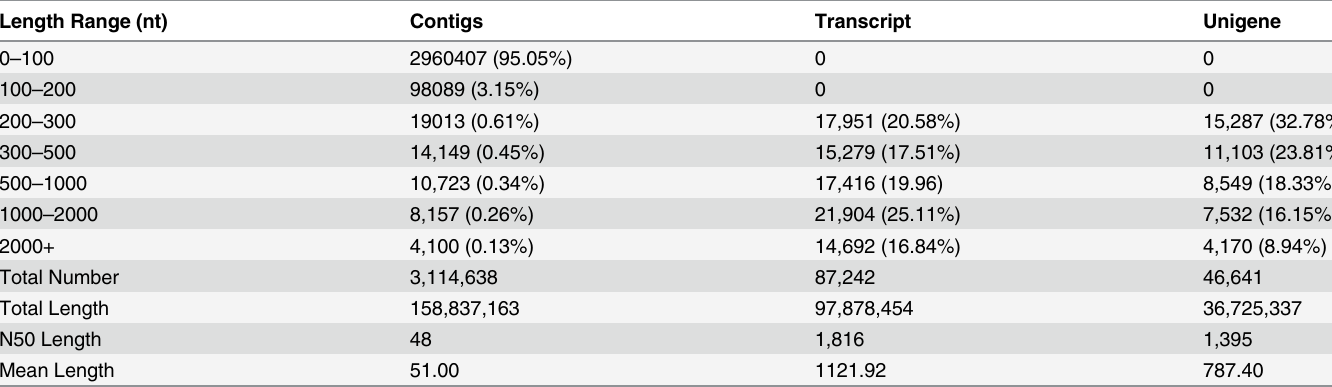
Table 1. Assembly results.